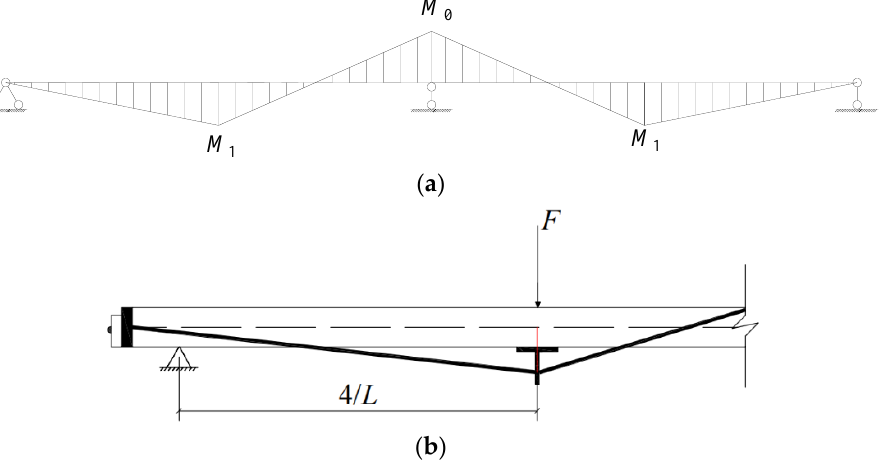
Figure 3. Moment distribution diagram. ( a ) Moment diagram of glulam continuous beam; ( b ) The corresponding distances from the unstressed neutral axis.